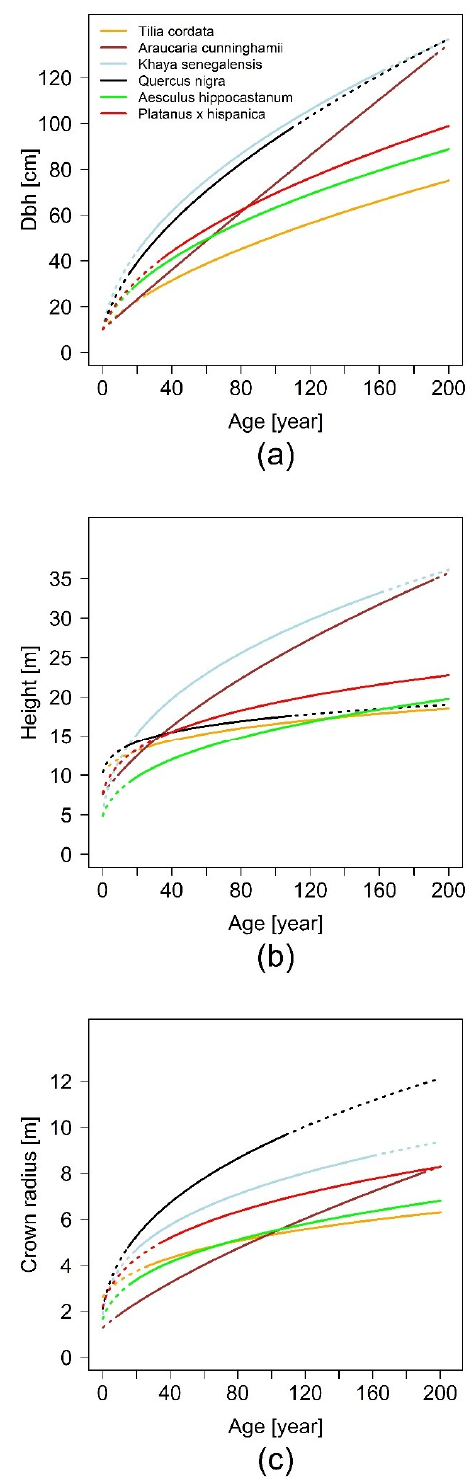
Figure 1. Allometric relationships for ( a ) diameter at breast height; ( b ) tree height; and ( c ) crown radius based on allometric model parametrizations for all six tree species (based on values of Tables 3–5). Dotted lines show projections which are not covered by measured data. For the stem diameter growth (Figure 1a) K. senegalensis in Hanoi shows the highest growth over 249 time, while the lowest was calculated for T. cordata in Munich. At an age of 100 years, for example, T. 250